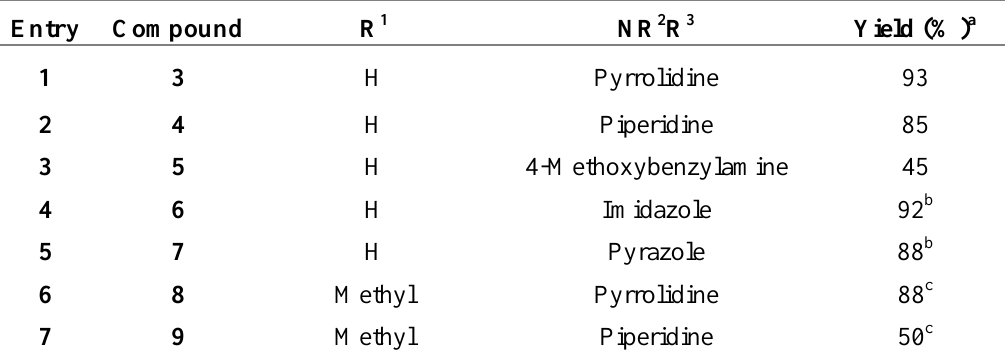
Table 2. Nucleophilic substitution of 6-fluoroquinoxalines with amines and nitrogen- containing aromatic